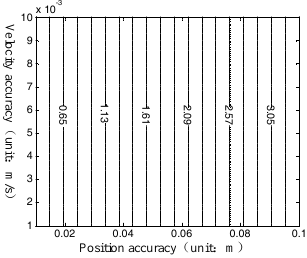
Figure 3 DGPS/ IMU accuracy’s influence to altitude